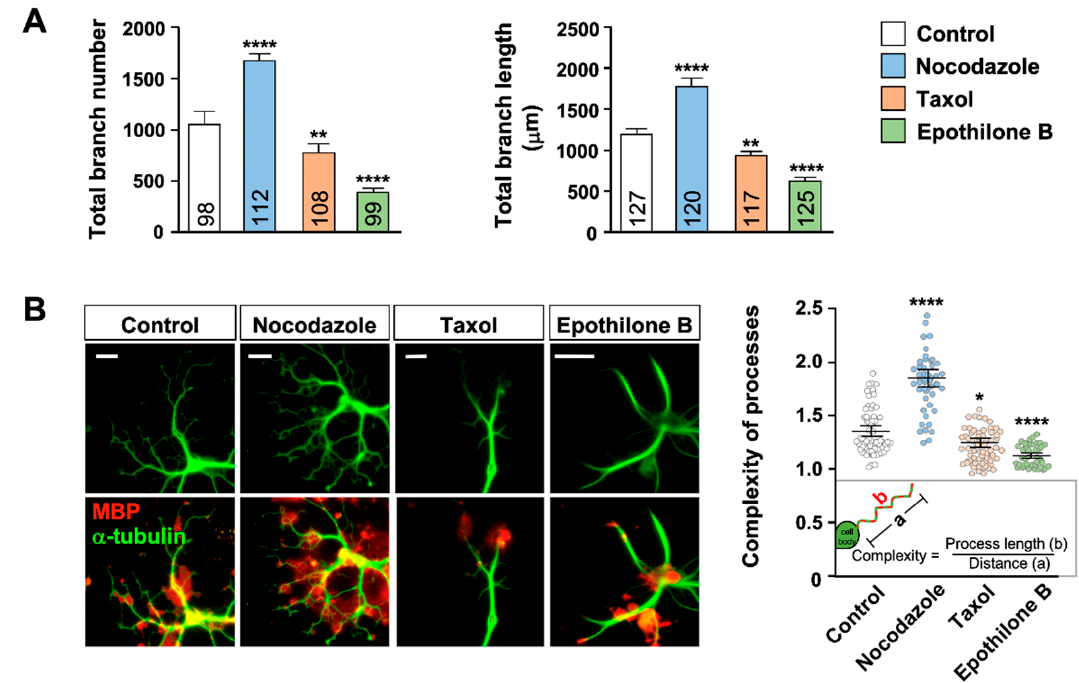
Figure 3. Effect of MTAs on oligodendrocyte morphology. ( A , B ) Oligodendrocytes were treated with MTA (2 nM) and immunostained with anti- α -tubulin and anti-MBP antibodies. ( A ) Number of branches of individual oligodendrocytes ( left ) and total branch length ( right ) were quantified. Graphs show mean ± SEM. Total numbers of cells pooled from at least seven independent experiments are depicted in each bar. ( B ) Representative images ( left ) and quantification of process complexity ( right ) of control and MTA-treated oligodendrocytes. Complexity was defined as the actual length of the process divided by the distance from the starting point of main branch to the distal tip. Graph shows mean complexity ± SEM of 42–75 cells pooled from at least four independent experiments. * p < 0.05, ** p < 0.01, and **** p < 0.0001, Student’s t -test.